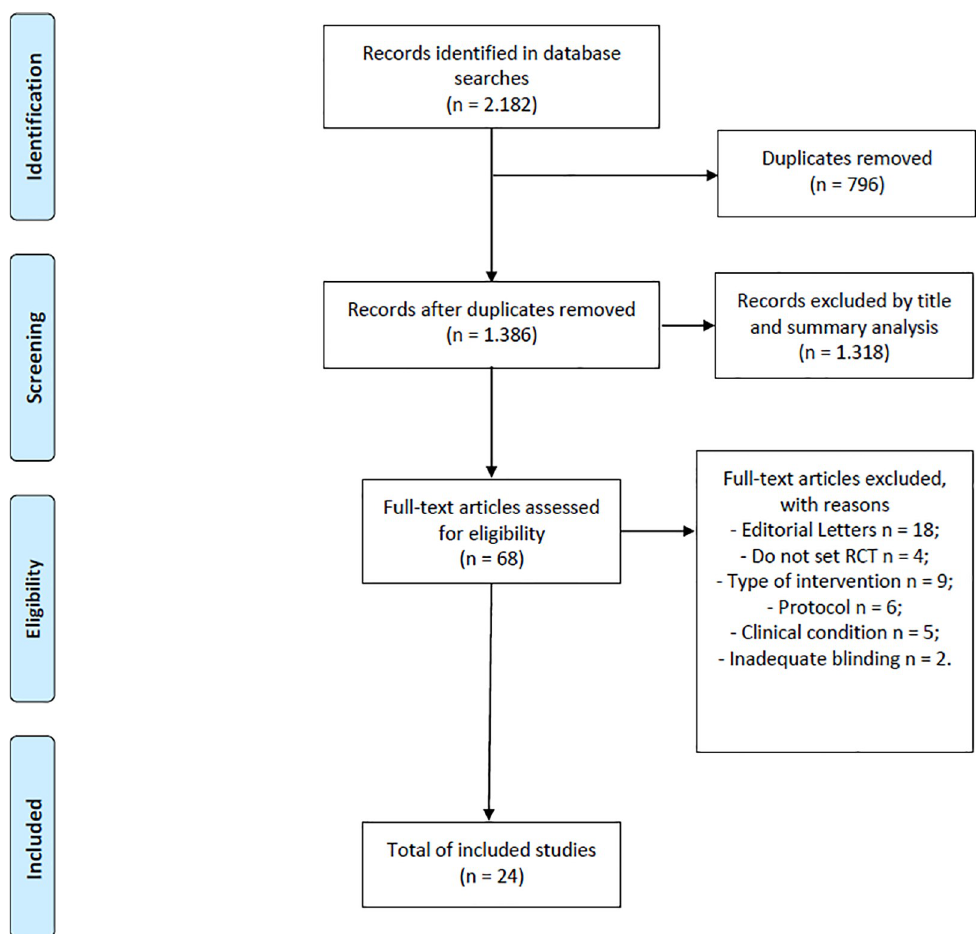
Fig 1. Flowchart of search and selection of